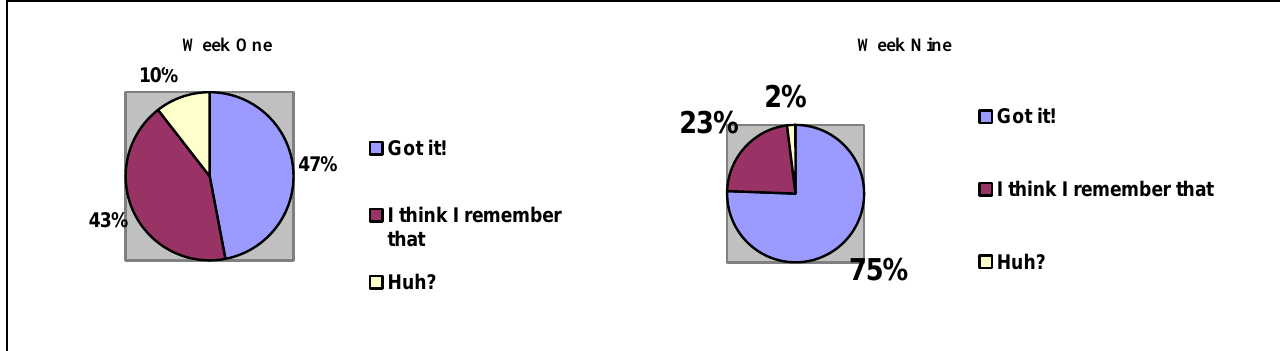
Figure 20. Week One and Week Nine Student Comprehension Checklist side by side